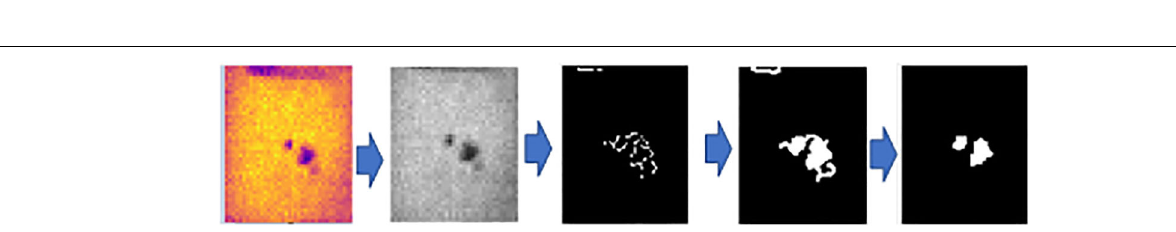
FIGURE 10 | Temperature profile for lightning and impact defect using thermoIMAGER TIM200.